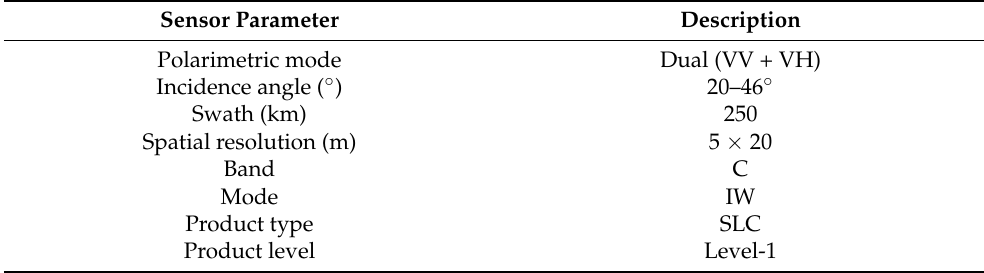
Table 1. Basic information of the Sentinel-1 data source.